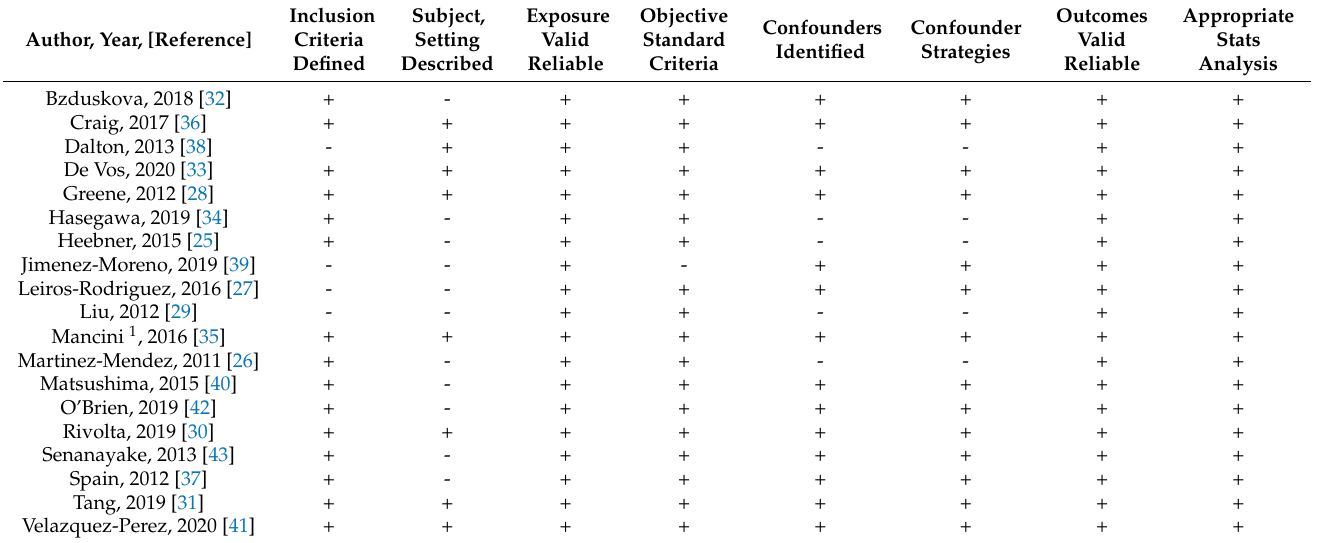
Table 2. Quality Assessment–JBI cross-section